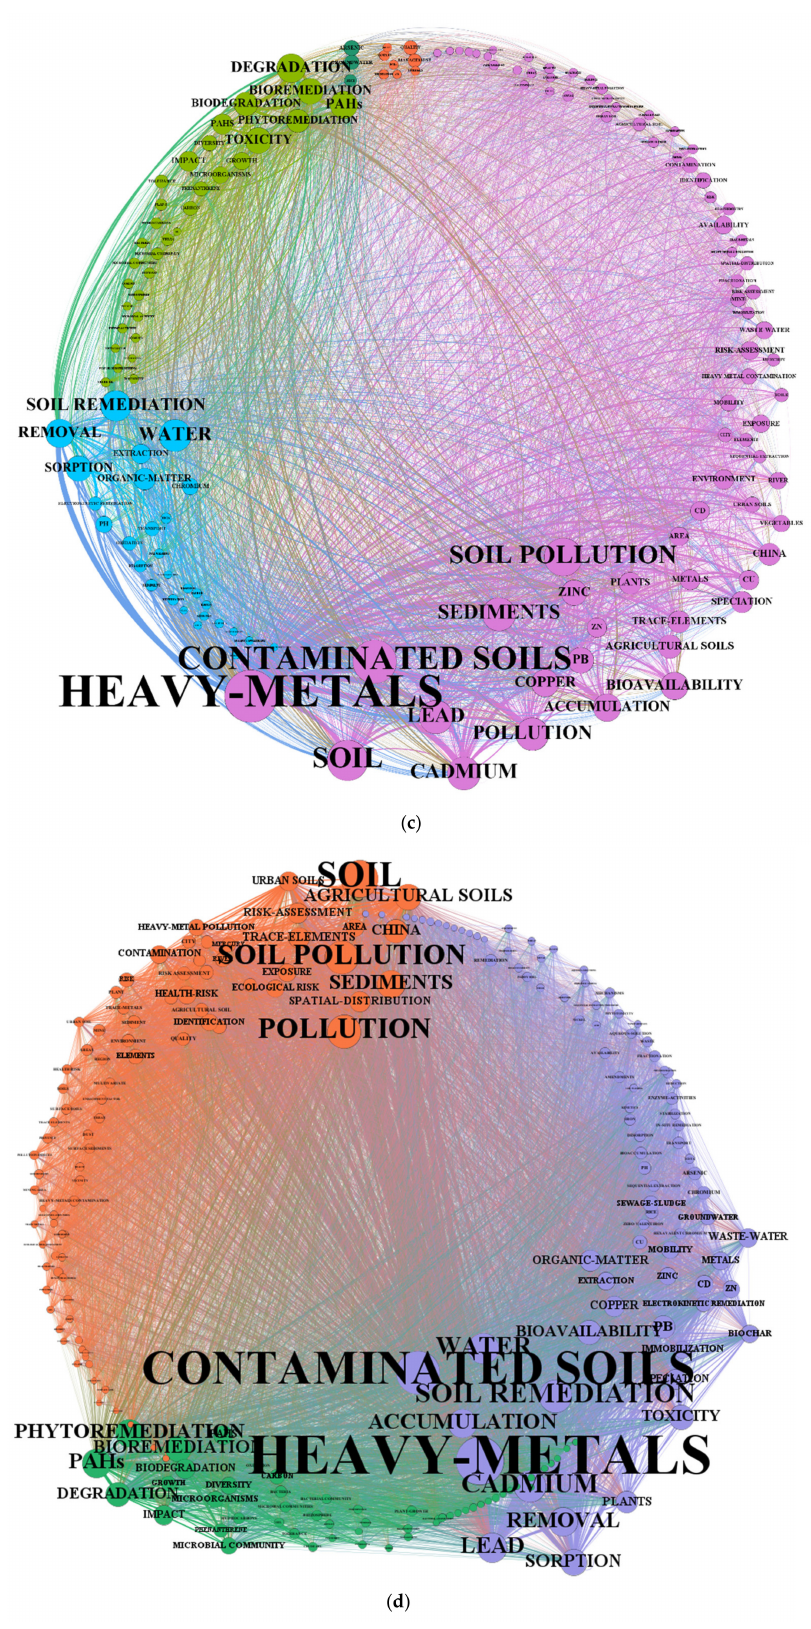
Figure 4. Keyword clustering for 4 time intervals: ( a ) 2001–2005, ( b ) 2006–2010, ( c ) 2011–2015, and ( d )